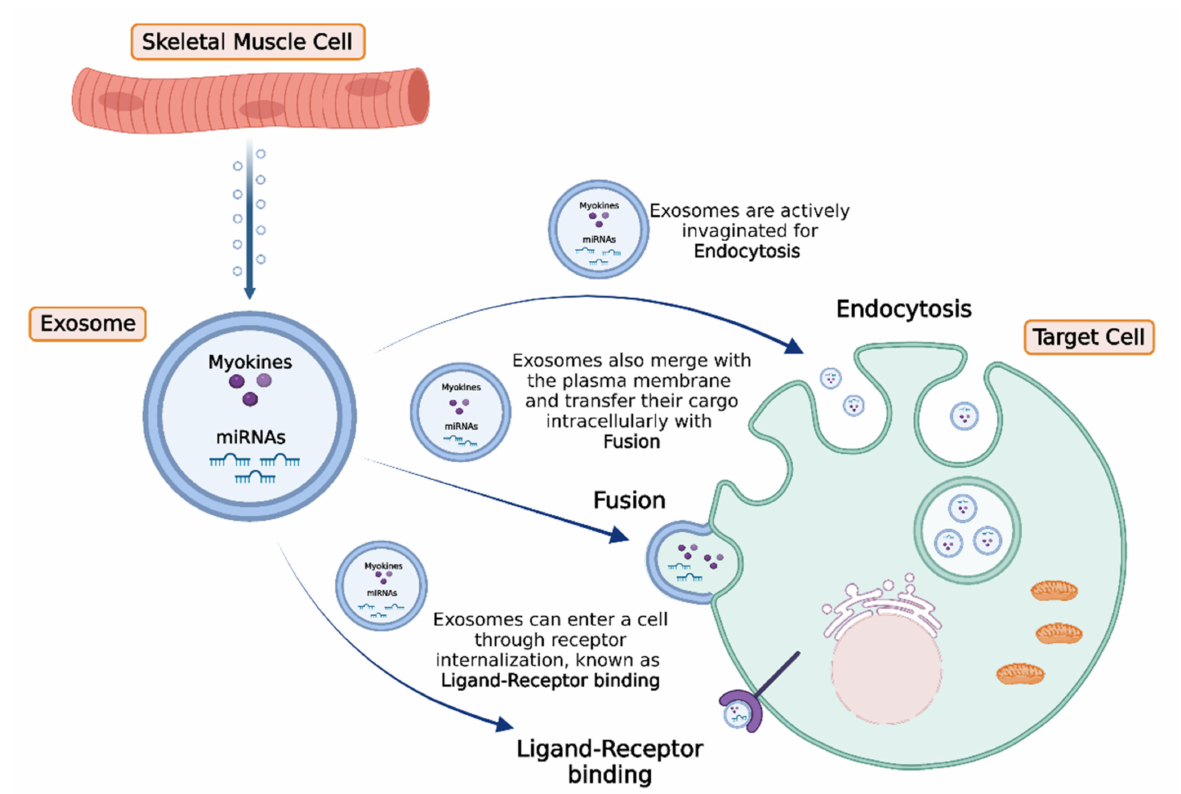
Figure 2. Exosomes are released from skeletal muscle cells in response to exercise stimuli, delivering their content (miRNAs and myokines) to target cells. Subsequently, target cells can uptake the exosomes by three main processes: (a) active endocytosis with invagination, (b) direct membrane fusion, or (c) internalization through ligand–receptor binding. The figure was created with BioRender. com (accessed on 10 February